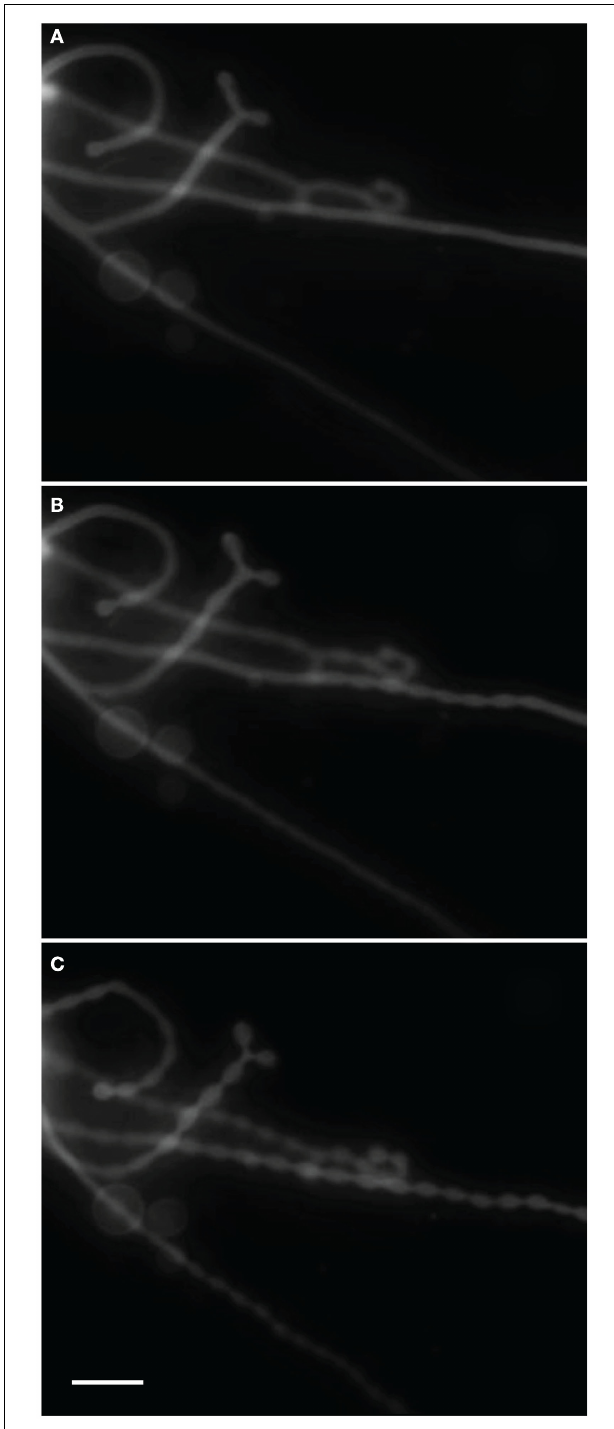
FIGURE 7 |Time series of Rho-DOPE stained (0.5%) POPC GUVs encapsulating 300mM sucrose and 100 μ M fluorescein diluted with MilliQ water. Pearling of hollow tubes initiated after 45min of incubation, presumably after the inversion of the osmotic gradient as a result of solute equilibration followed by sample evaporation. (A) Tubes just prior to the onset of pearling. (B) Intermediary tube-pearl state after 6s. (C) Pearled state after 23s. Scale bar: 20 μ